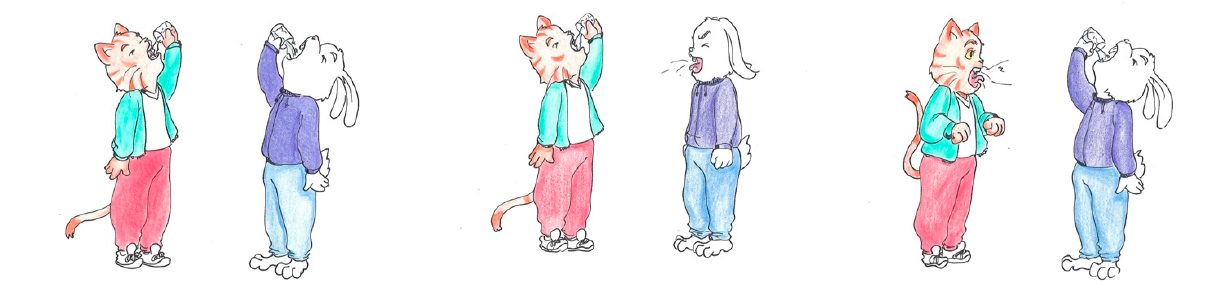
Figure A33. Filler stimulus 8.